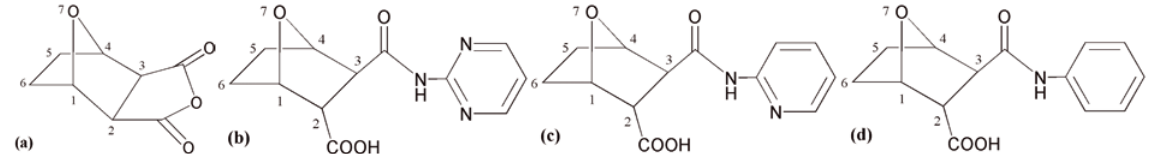
Figure 1. Structures of NCTD(a), HL 1 (b), HL 2 (c) and HL 3